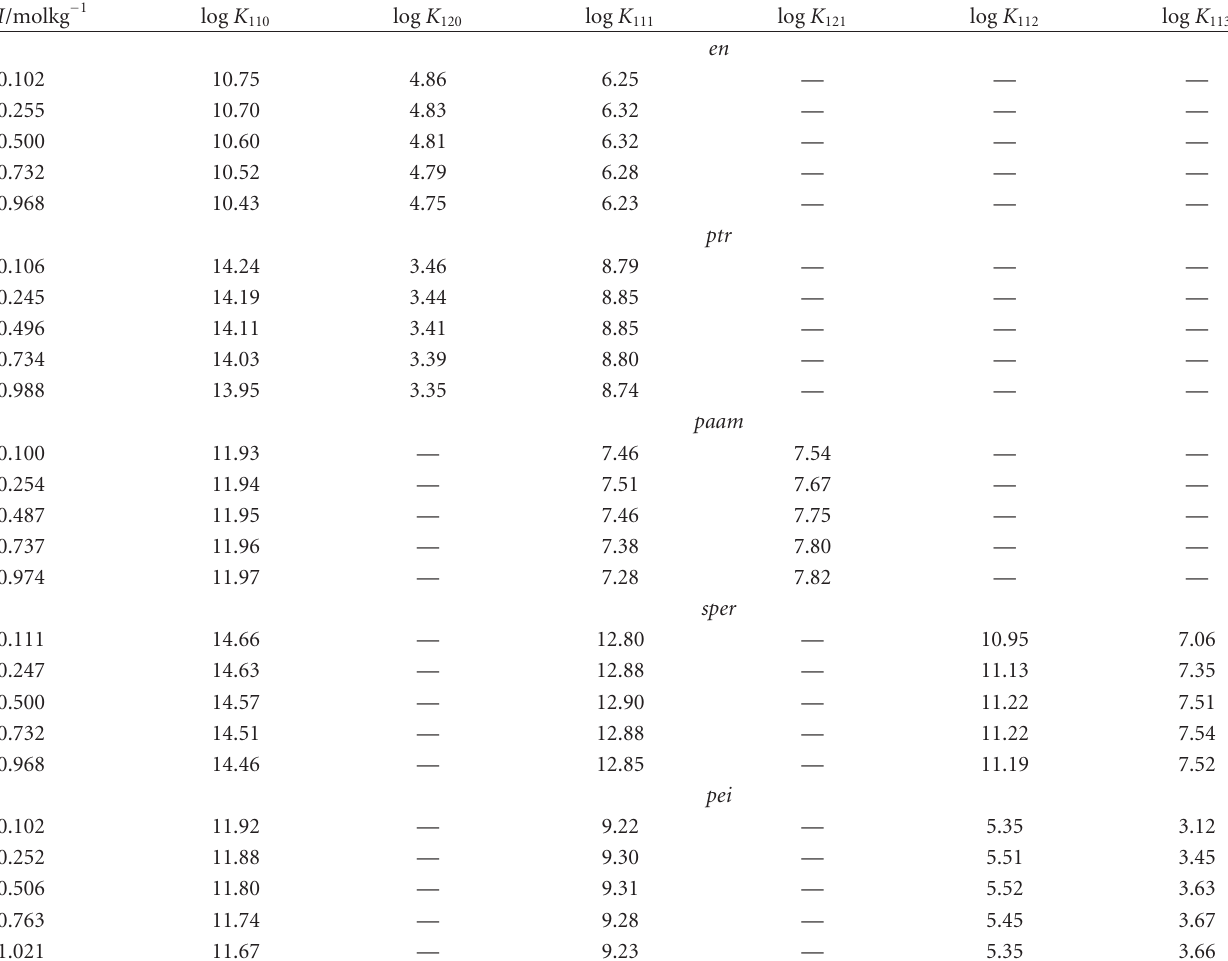
Table 6: Stability constants of dimethyltin(IV)/amine species, in NaCl aq at di ff erent ionic strengths (in mol kg − 1 H 2 O) and t = 25 ◦ C. log K pqr refer to equilibria reported in (2)–(4).